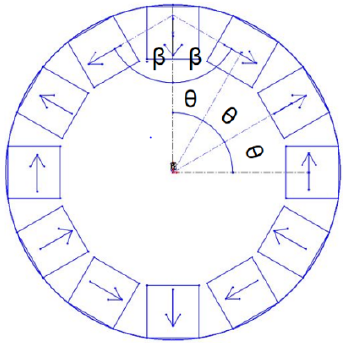
Figure 1. Permanent magnet arrangement of Halbach array. For the Halbach array rotor with two permanent magnets per pole, each individual permanent magnet of the Halbach array is magnetized in a single direction, arranged in the radial and circumferential directions. The radially arranged permanent magnets mainly produce magnetic poles, and the tangentially arranged permanent magnets mainly guide and enhance the magnetic flux [19–21]. Because the unique structure of Halbach array can enhance the magnetic field strength on one side, its energy harvesting effect will also be better. The Halbach array generates a sinusoidal magnetic field. When a ferromagnetic material is placed in the magnetic field, the ferromagnetic material is magnetized to produce an additional magnetic field. Magnetized body current J m appears in the ferromagnetic material after magnetization; Magnetizing surface current K m appears on the ferromagnetic